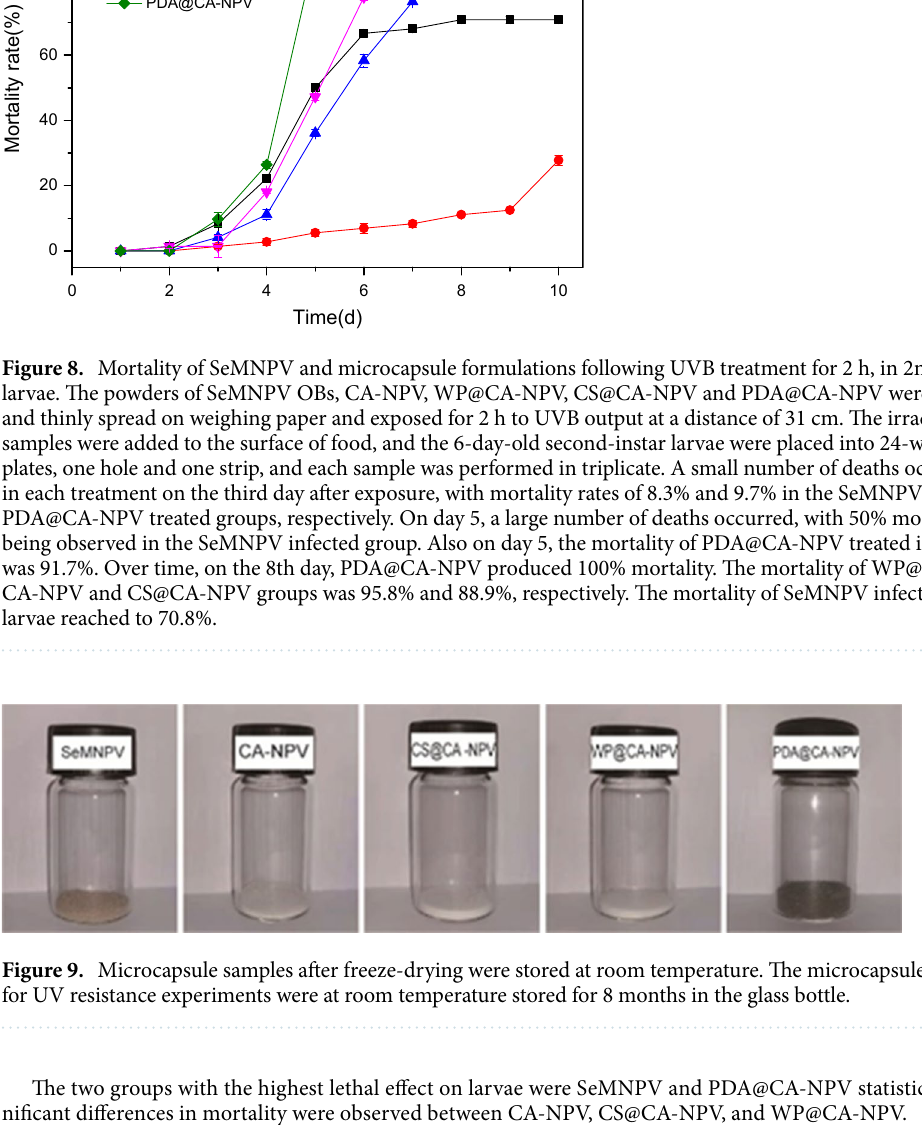
100% mortality. The mortality of WP@CA-NPV and CS@CA-NPV groups was 95.8% and 88.9%, respectively. The mortality of SeMNPV infected larvae reached to 70.8%, indicating WP@CA-NPV and CS@CA-NPV were